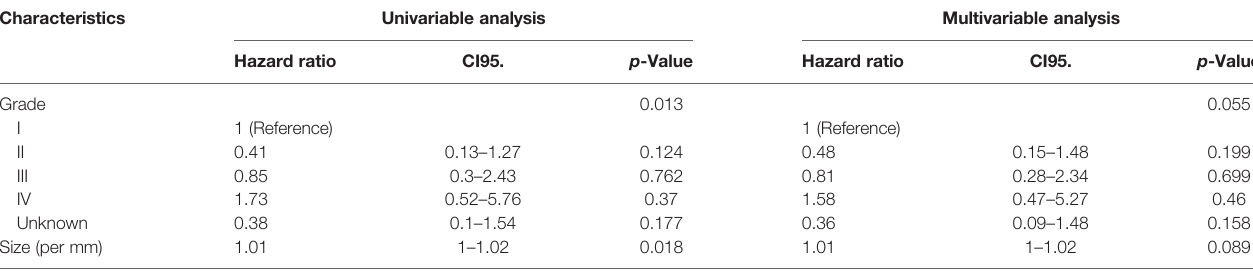
TABLE 7 | Univariate and multivariate analyses of CSS in the venous invasion cohort. Characteristics